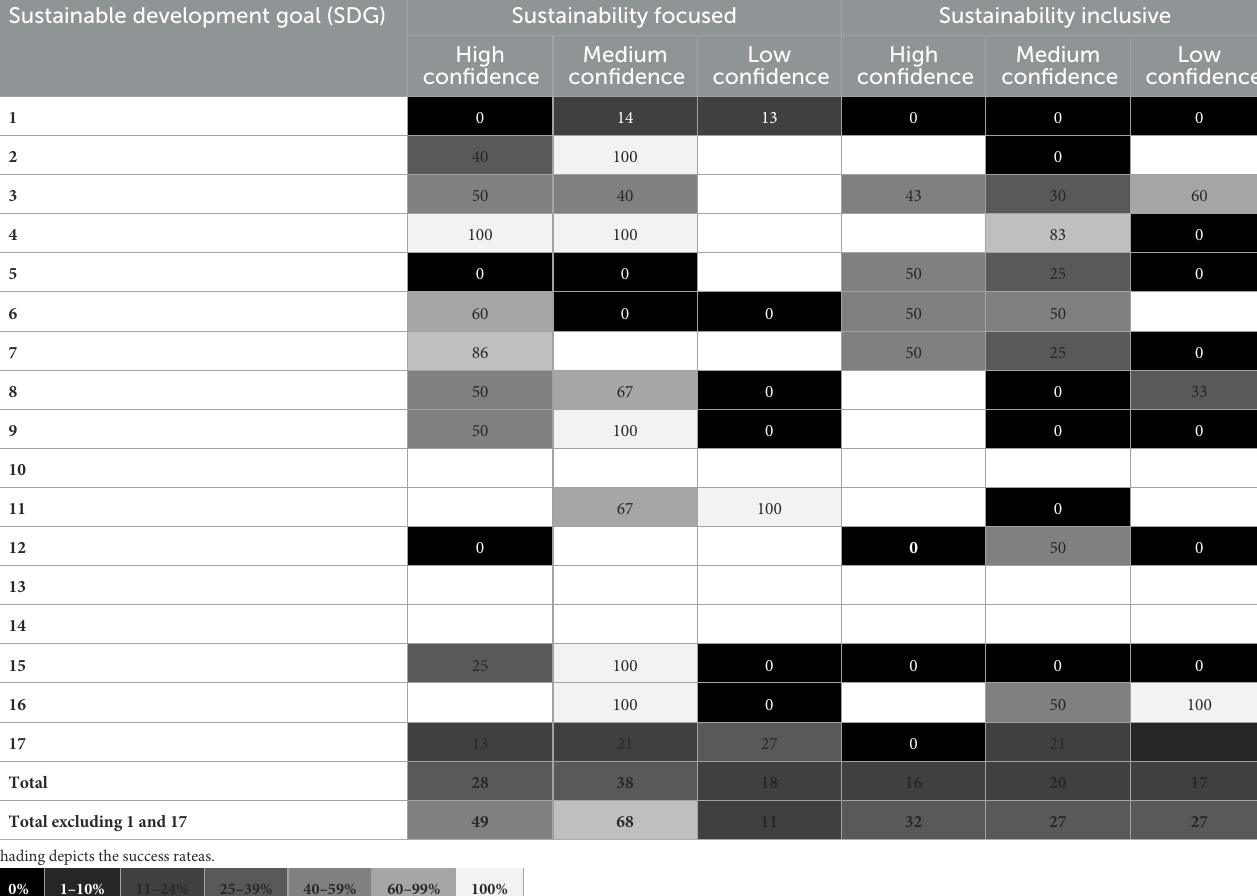
TABLE 6 Overall success rates (%) for modules/courses with sustainable components. Sustainable development goal